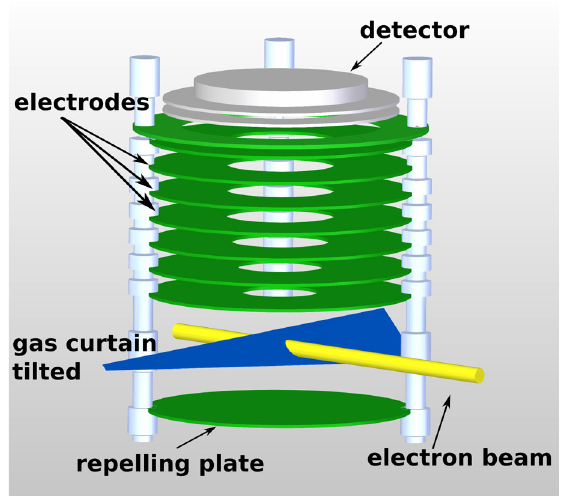
FIG. 5. Extraction field scheme and particle beam-gas jet interaction